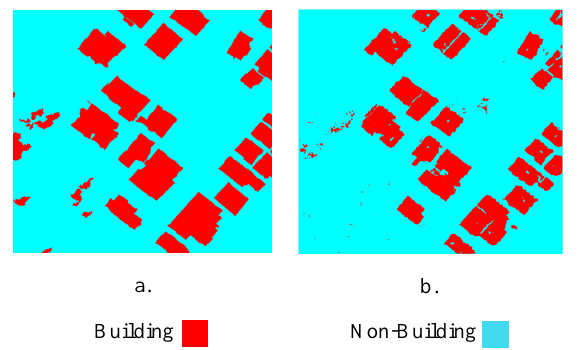
Figure 9. The Classified images obtianed from a. Object -SVM- ACO R Clasification , b. RF